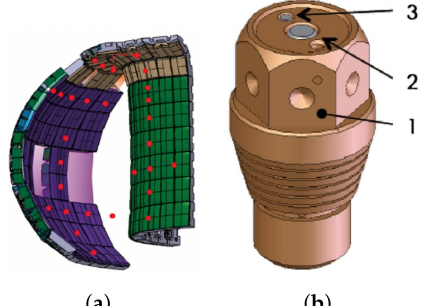
Figure 17. ( a ) Illustration of FWS distribution (red spots). ( b ) Conceptual design: 1. sample body, 2. Be insert with markers, 3. reference point. Reprinted with permission from Ref. [11]. Credit c (cid:13) ITER Organization,